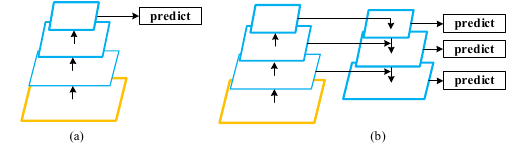
Figure.2 The framework of Faster RCNN